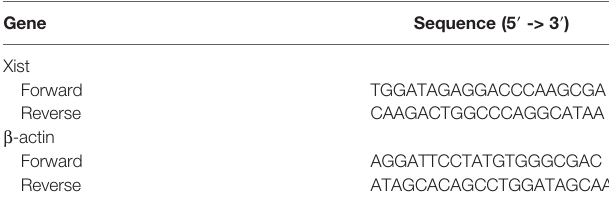
TABLE 1 | Sequences of primers for real-time quantitative polymerase chain